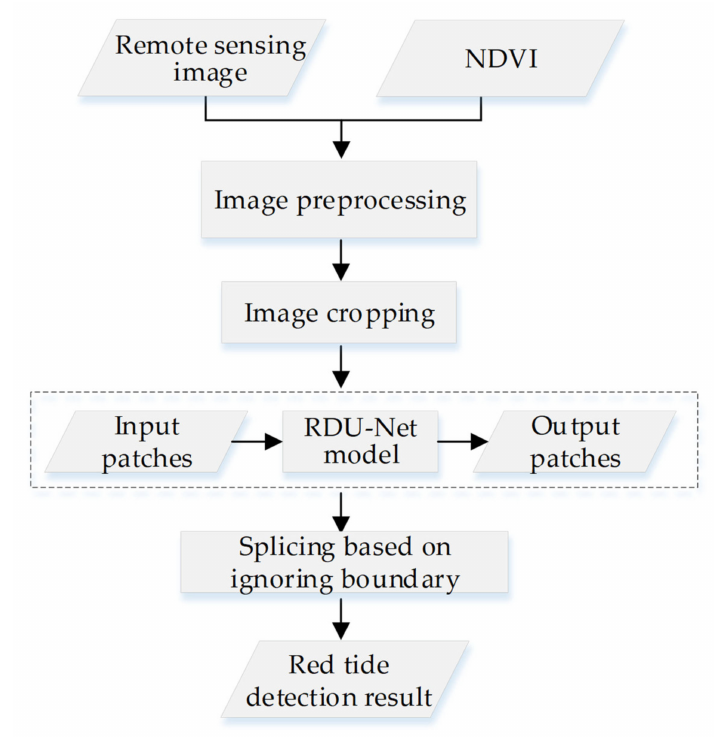
Figure 5. Flowchart of the proposed